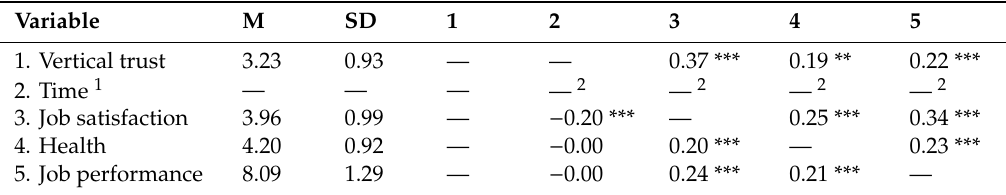
Table 2. Intercorrelations between the study variables (Level 1 and 2).